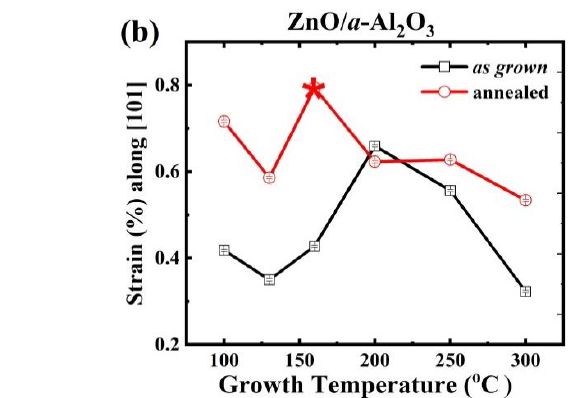
Figure 7. ( a ) The values of strain along the c ([001]) direction in as grown (open square) and annealed(open circle) ZnO/Si films and ( b ) along the [101] direction in as grown (open square) and annealed (open circle) ZnO/a-Al 2 O 3 films; the star indicates the only layer with the [001] preferred orientation.